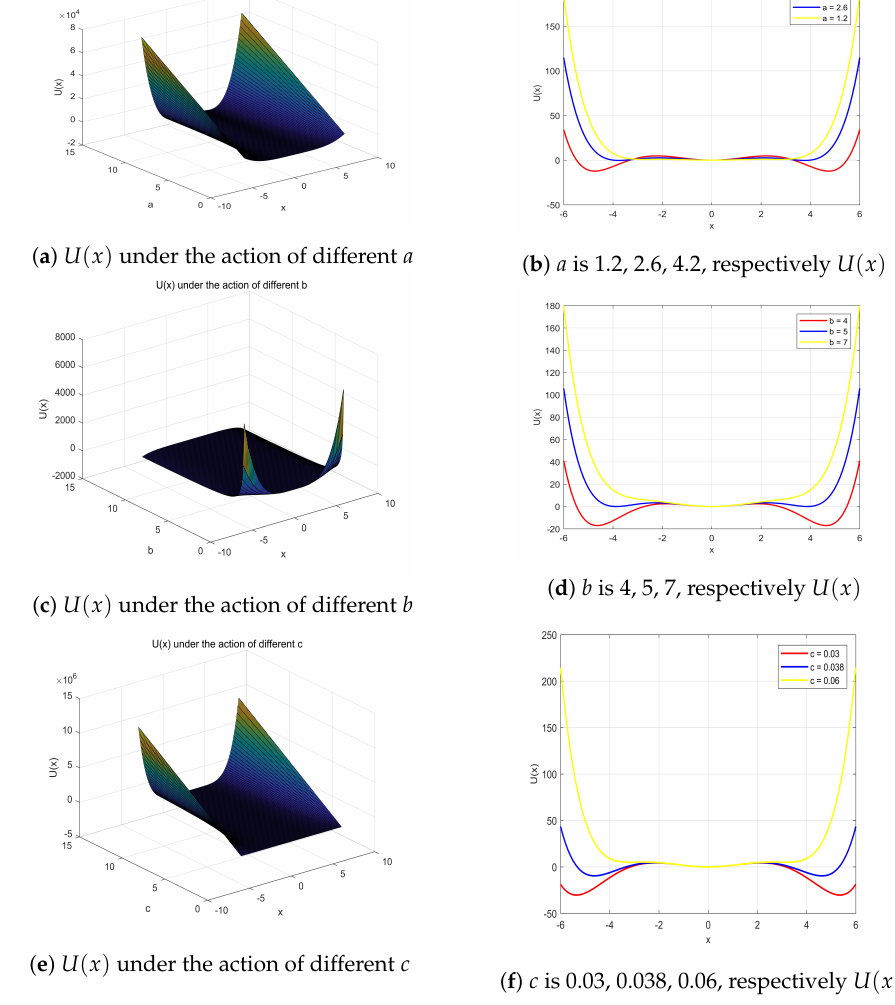
Figure 3. Potential function U ( x ) under different system